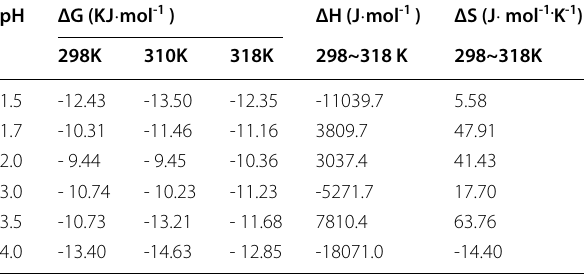
Table 3 Inclusion thermodynamic parameters at different